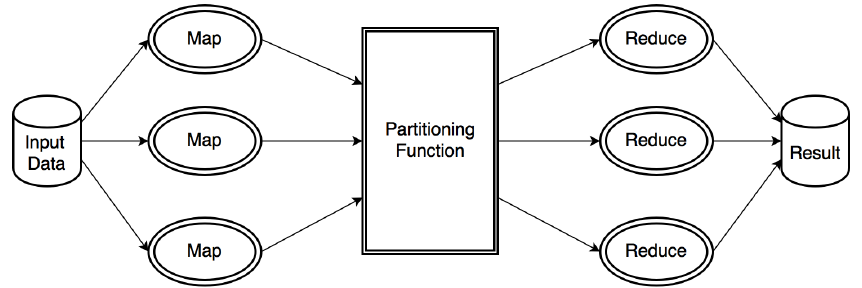
Figure 1. MapReduce